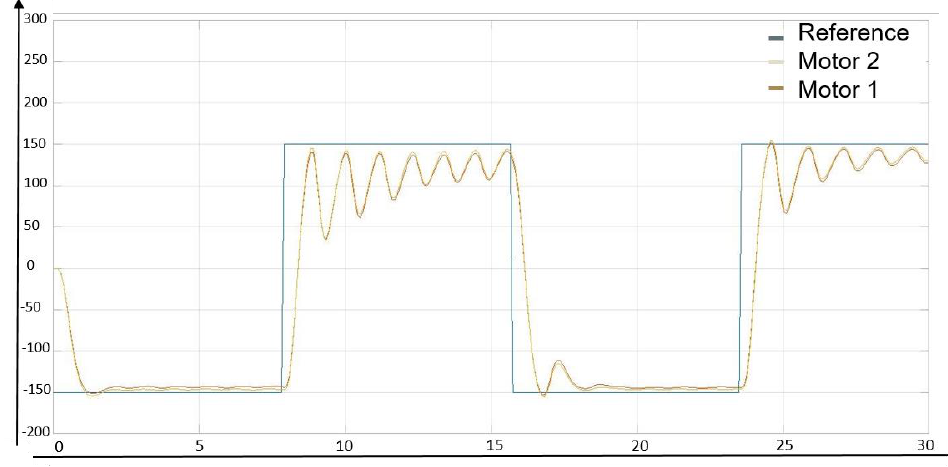
Figure 5. Behavior using PI traditional control.